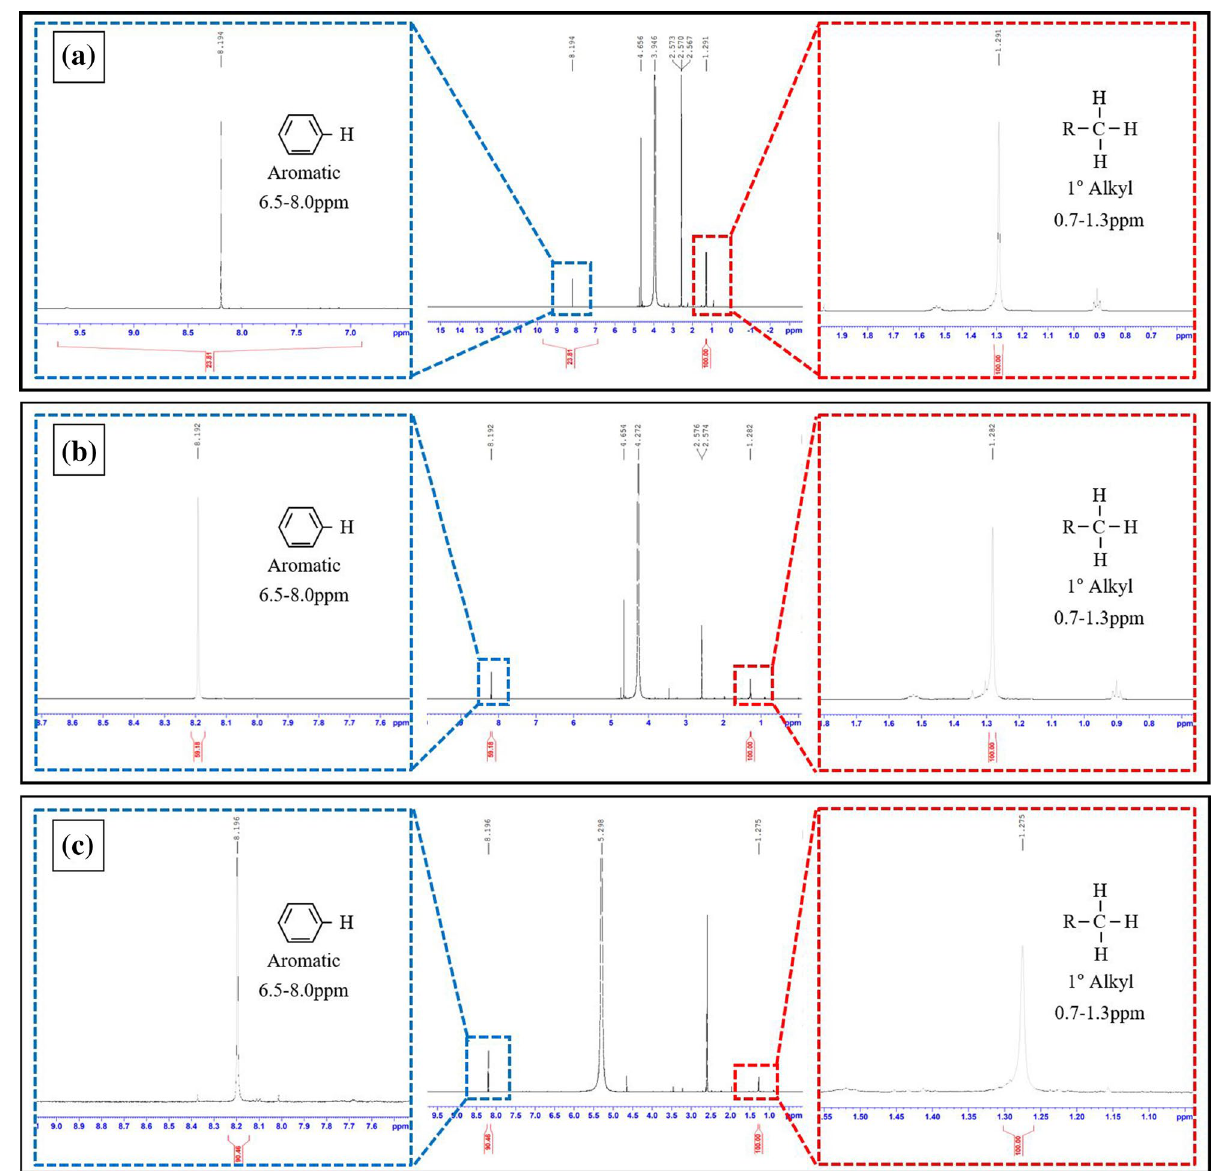
Figure 8. 1 H NMR spectrum and hydrogen peak assignments of sulfonated partially drawn LLDPE fibers under sulfonation conditions of 5 bar for 2.5 h ( a ) PSL1.1, ( b ) PSL10, ( c )